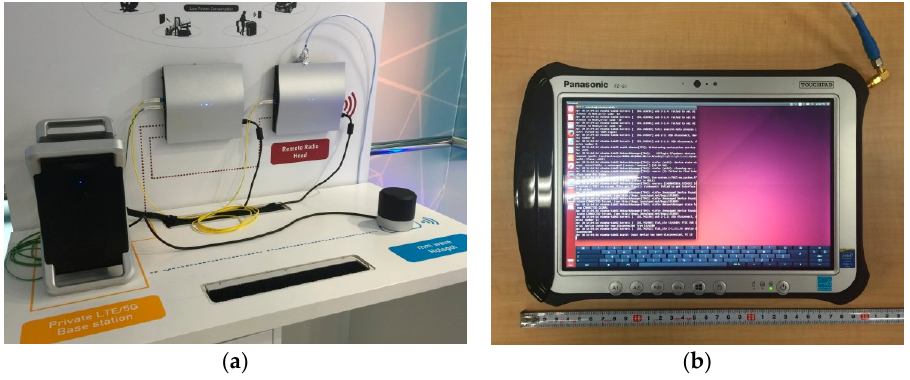
Figure 12. PoC for LTE-WiGig-integrated HetNet: ( a ) LTE eNB, RRH and WiGig AP and ( b ) dual-connectivity UE with LTE and WiGig modules.